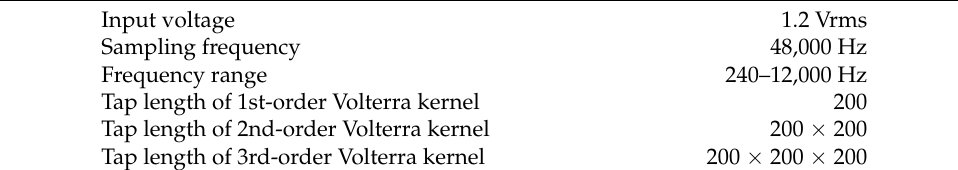
Table 2. Identification conditions of the 3rd-order nonlinearity of the target micro-speaker.